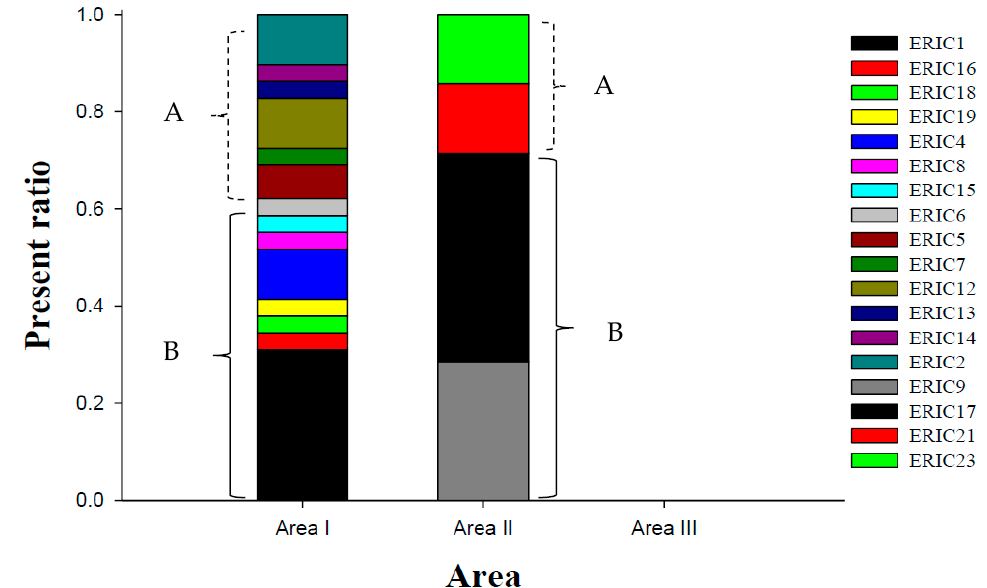
Figure 3. Geographical distribution of the L. innocua ERIC types in the three sampling areas. A is group A, and B is group B as determined by the minimum spanning tree analysis shown in Figure 2.